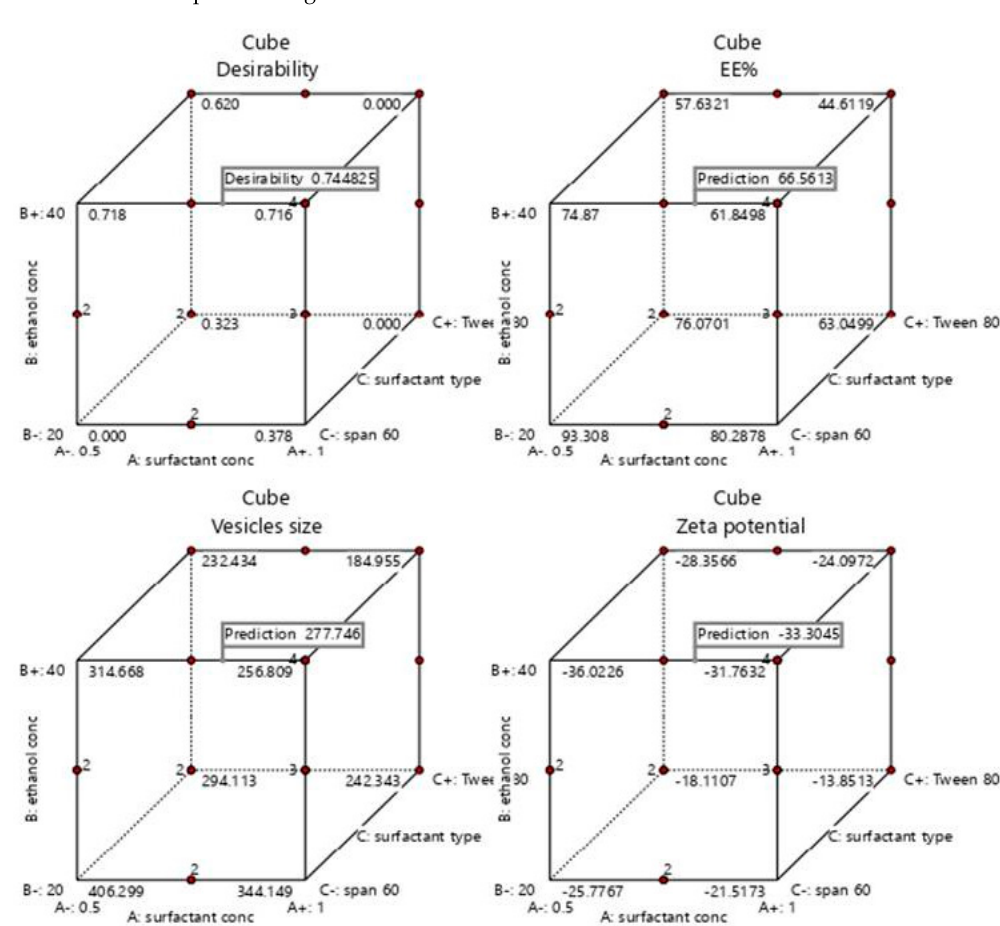
Figure 3. The composition of the optimized formula with its expected responses according to I optimal design.